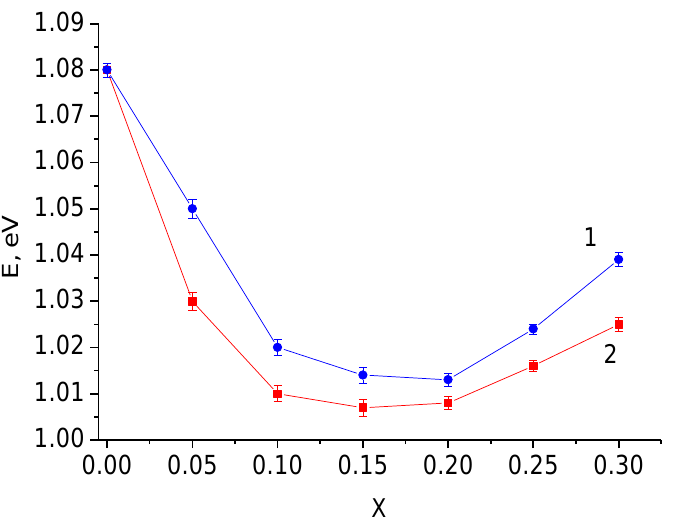
Figure 12. Concentration dependence of activation energy for Li 6-x Zr 2-x A x O 7 A = Nb (1), Ta (2).